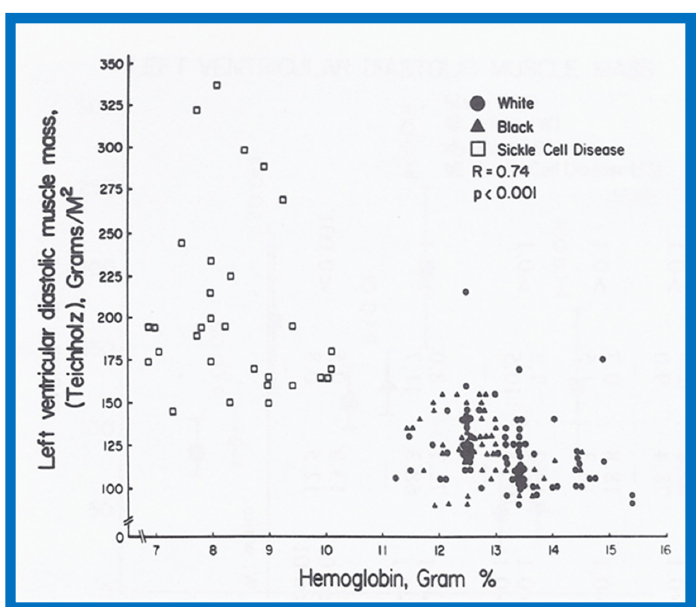
Figure 31. Left ventricular muscle mass in diastole calculated by Teichholz method is plotted against hemoglobin. Note significant ( R = 0.74; p < 0.001) correlation between these parameters. Similar correlations were noted between the diastolic and systolic left ventricular muscle mass calculated by all three methods on the one hand, and hemoglobin values on the other. Reproduced from Rao P.S., et al. [9]. Table 2. Left Ventricular Muscle Mass by